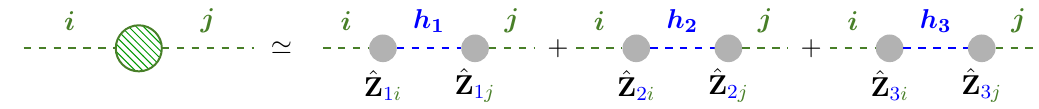
Figure 2 . Diagrammatic illustration of the full mixing Higgs propagators compared to the Breit- Wigner propagators where the ^ Z -factors encode the transition between the interaction and the mass